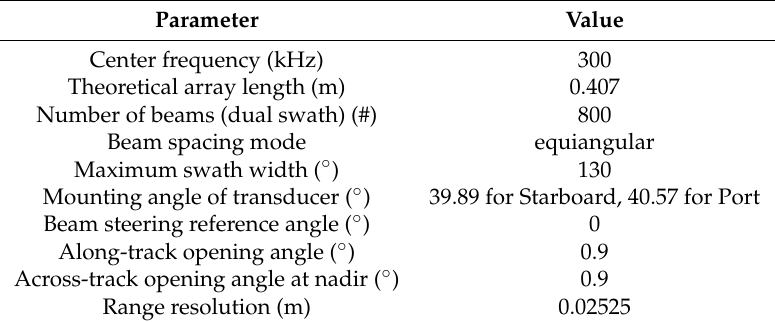
Table 1. Characteristics of EM2040C [29] in the dual head